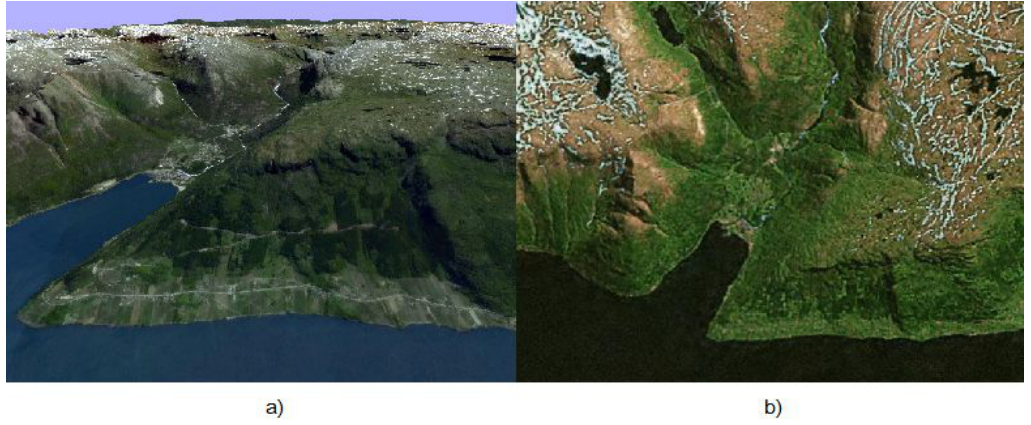
Figure 1. ( a ) Image I c of the on-board camera of the UAV; ( b ) template image loaded in the UAV memory in